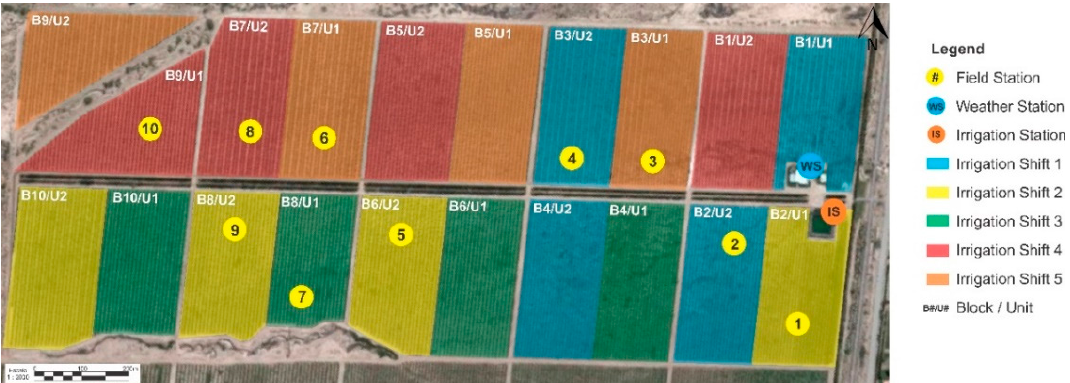
Figure 11. Distribution of twenty irrigation units, arranged in five irrigation shifts (marked in colors). The location of the measurement stations is indicated with circles.